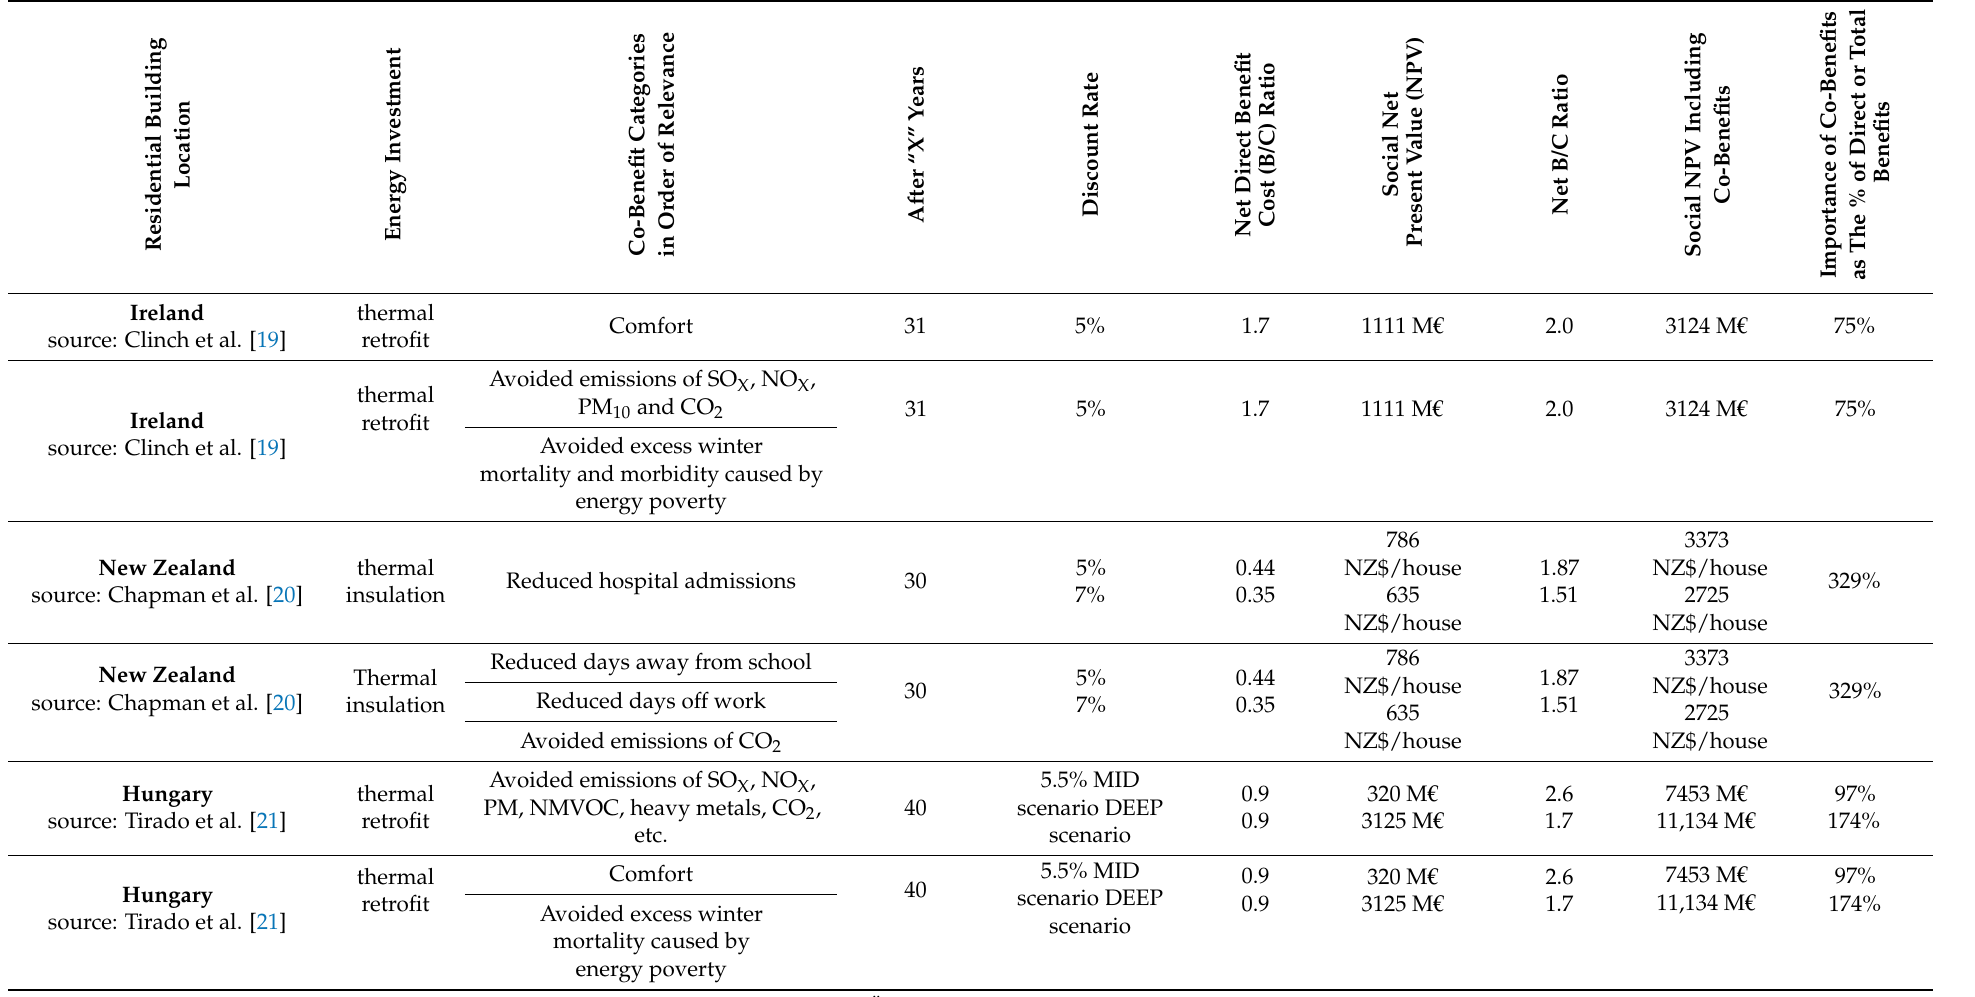
Table 1. Quantitative assessment of the importance of co-benefits for selected case